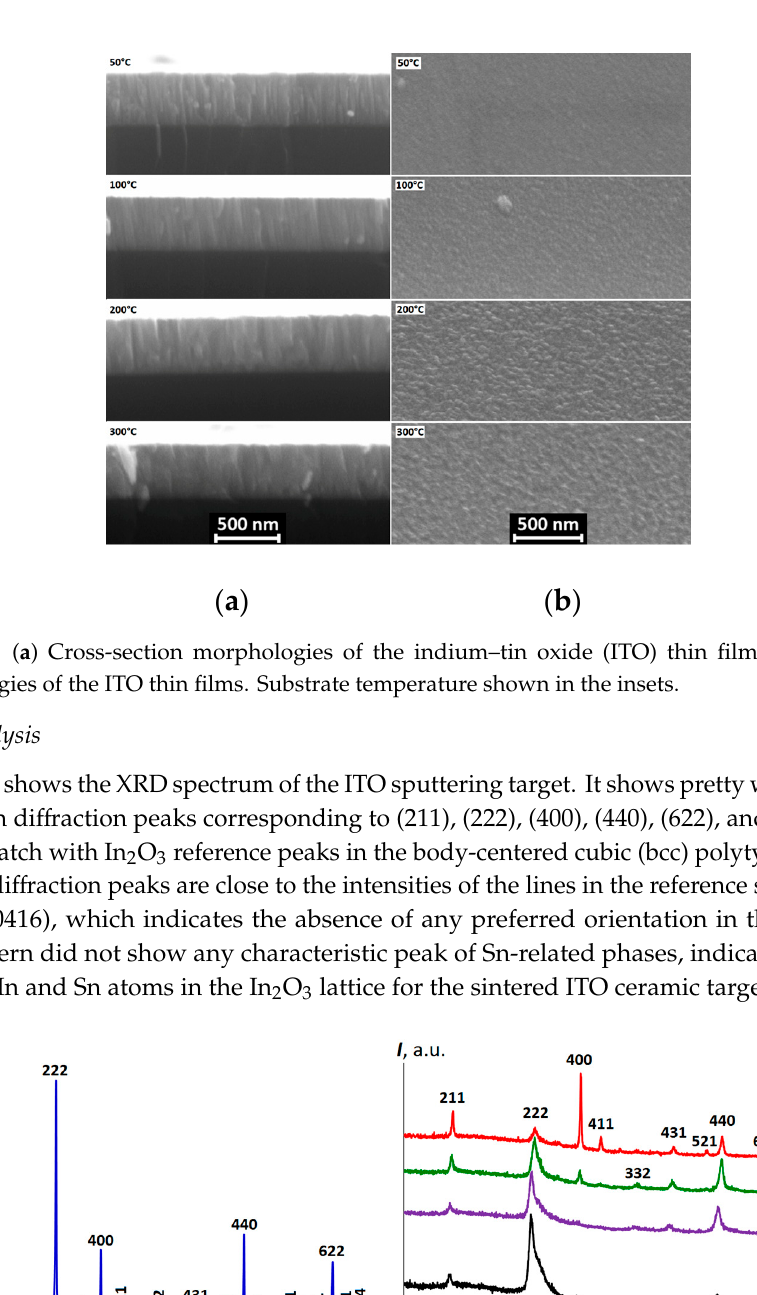
Figure 2. ( a ) Cross-section morphologies of the indium–tin oxide (ITO) thin films; ( b ) Surface morphologies of the ITO thin films. Substrate temperature shown in the insets.